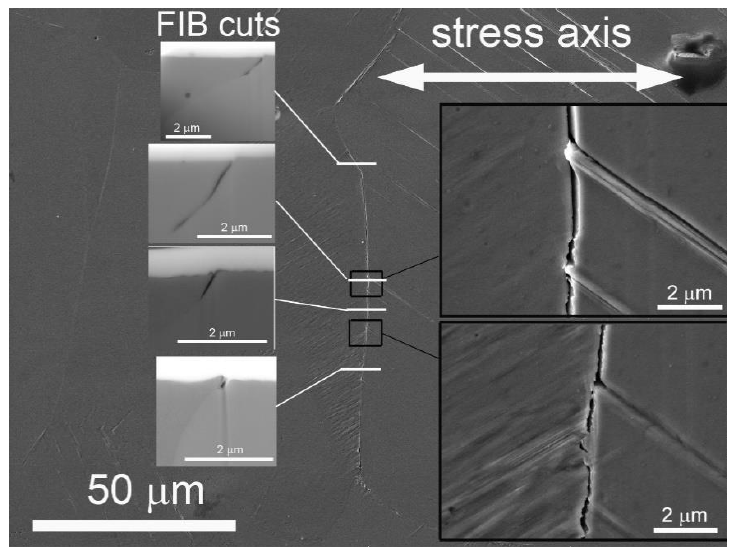
Figure 21. Surface of polycrystalline copper cycled with ε L = 4 × 10 − 3 for 4000 cycles (4% N f ). A cracked grain boundary is oriented perpendicular to the stress axis. The details of the impinging PSMs and FIB cuts showing the local crack direction and depth.